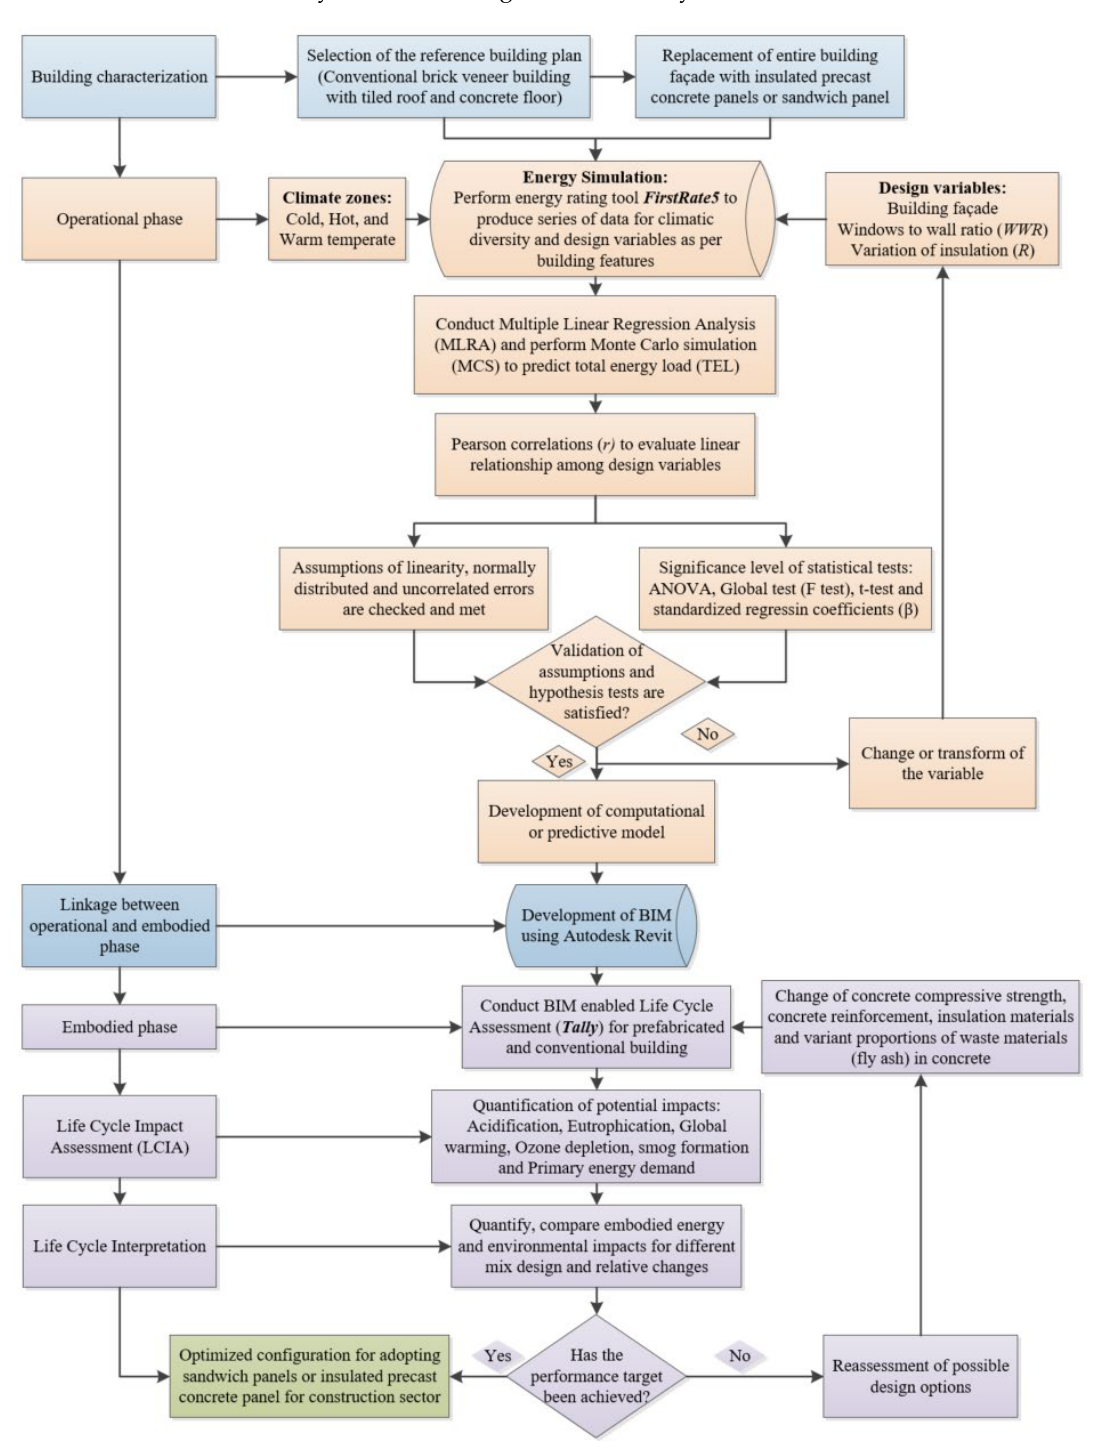
Figure 1. An analytical framework to determine the optimized configuration of precast concrete panels.